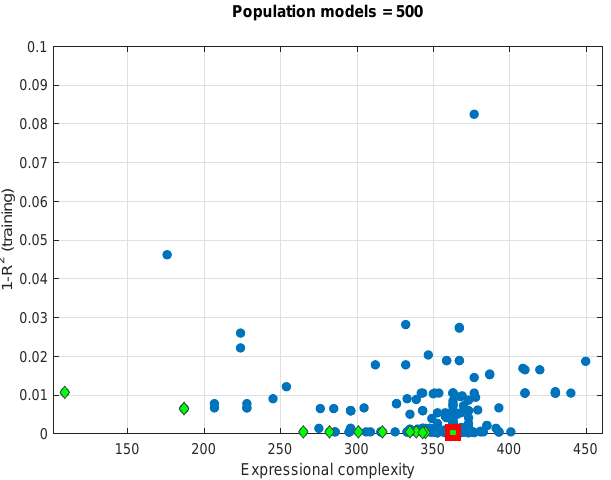
Figure 7. Multigene regression model population. Diamonds represent the Pareto front of models visualizing the model performance ( 1 − R 2 ) and complexity. Non-Pareto models are represented with dots. The best model (in terms of R 2 ) on the data used for training in the population is represented with a